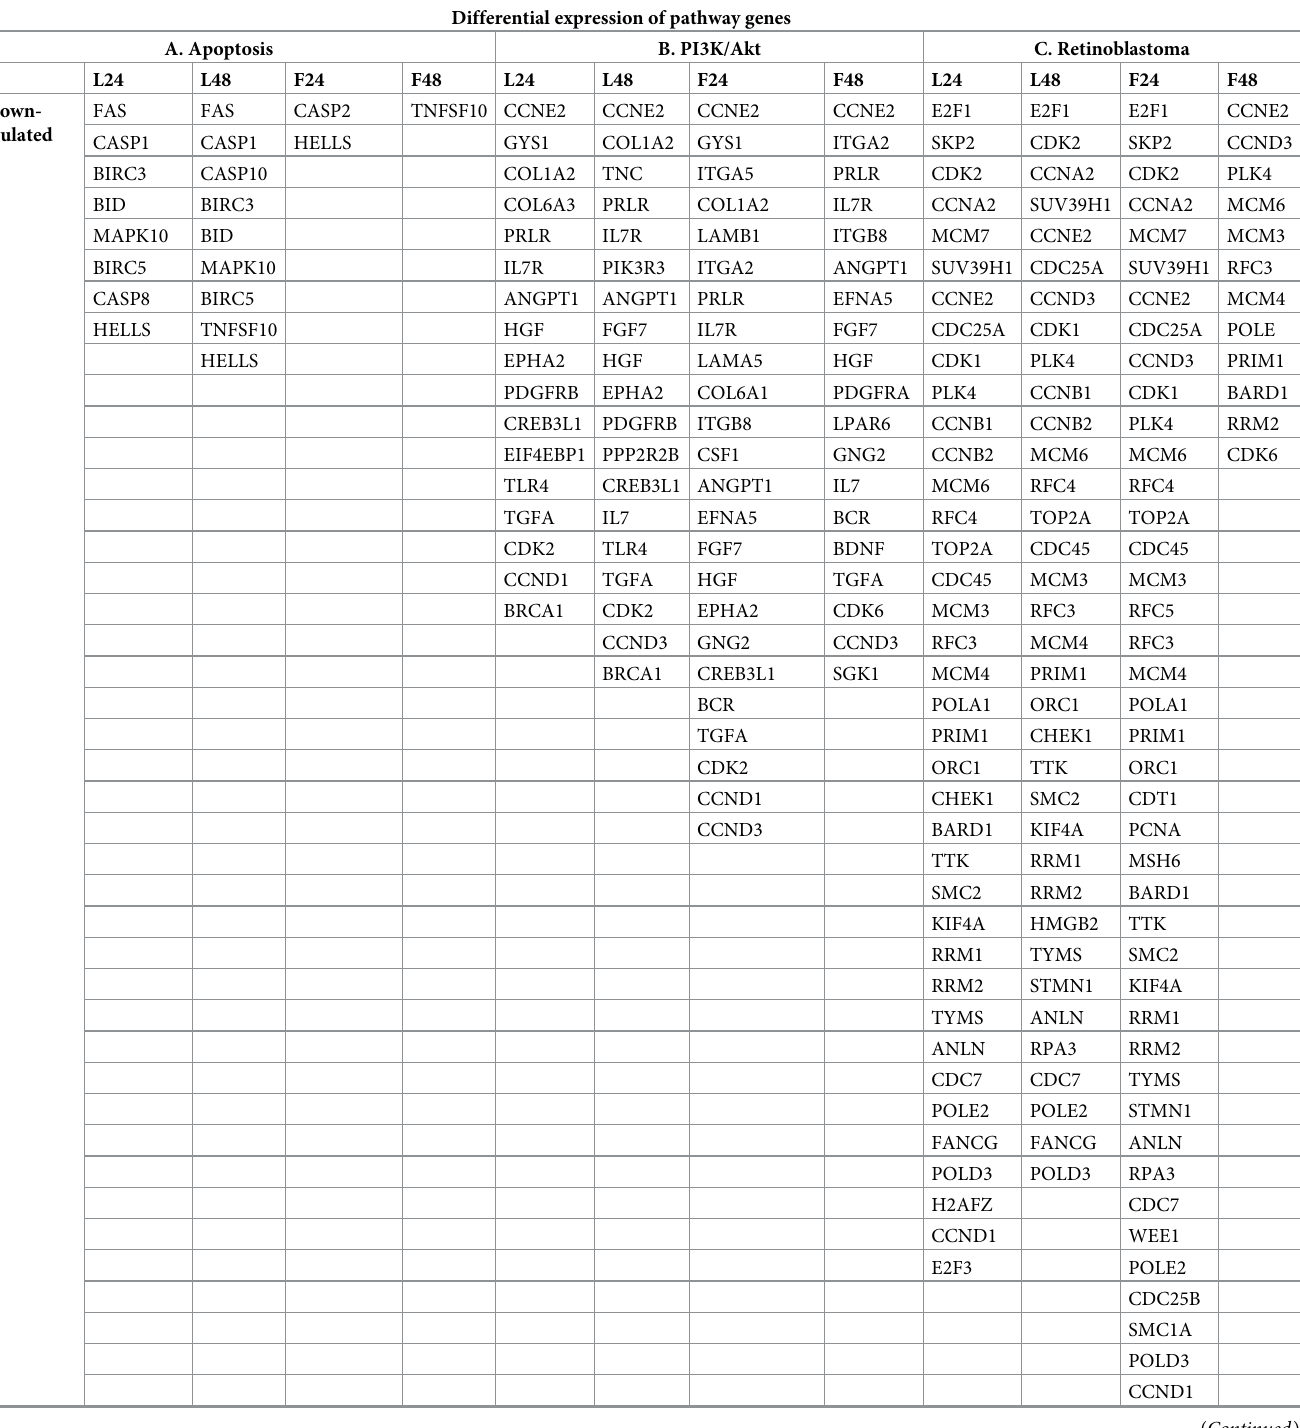
Table 2. WikiPathway analysis. A, Apoptosis, B, PI3K/Akt, C, Retinoblastoma. L24, genes affected by LY-294002 at 24h; L48, genes affected by LY-294002 at 48h; F24, genes affected by fucoxanthin at 24h; L48, genes affected by fucoxanthin at 48h. All genes are listed in order of their level of